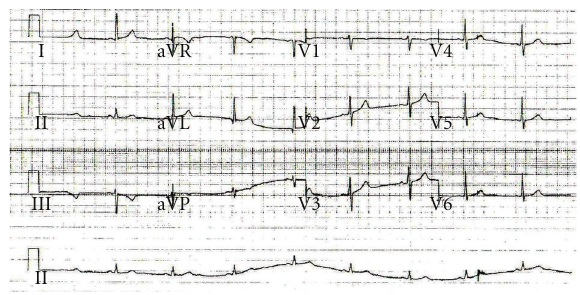
Figure 2: ECG fifteen minutes after the patient attended to A&E.